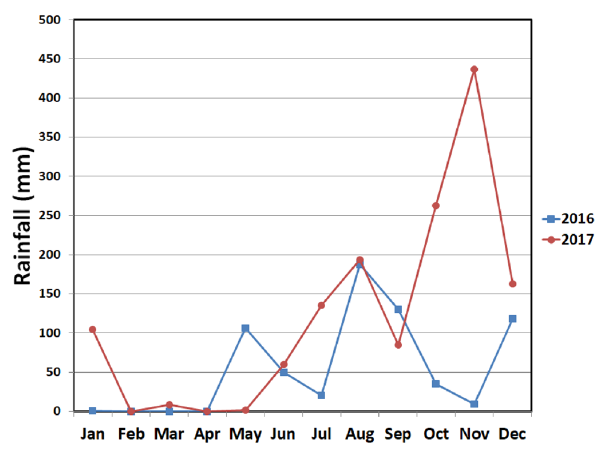
Fig. 4 Monthly rainfall in millimeter for the year 2016 and 2017